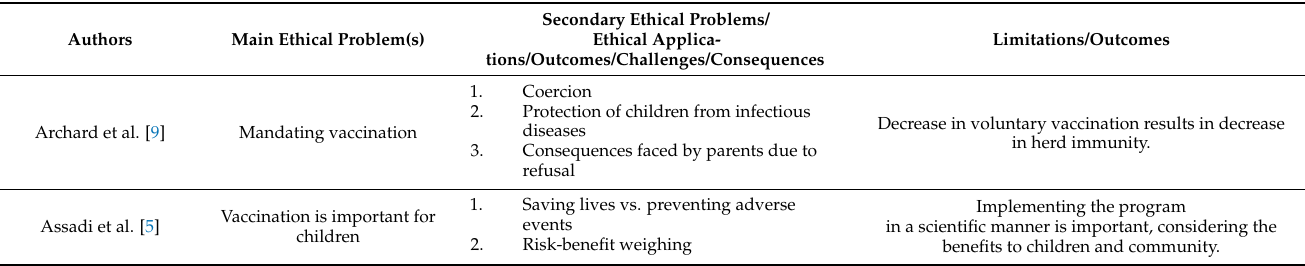
Table 2. Primary and Secondary Ethical issues focused in included